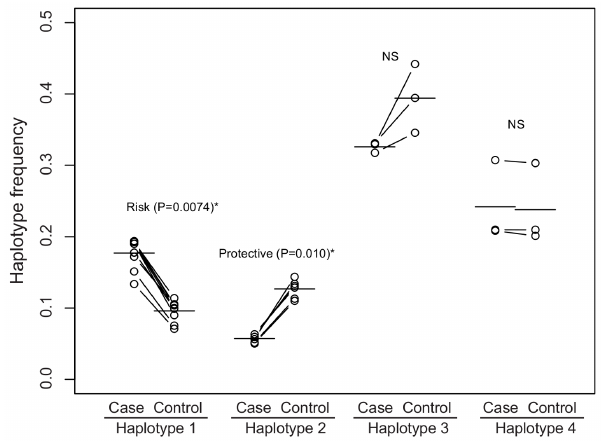
Figure 4. Haplotype frequencies in case and control pools. The haplotype frequencies were estimated from allele frequencies of tag SNPs with r 2 . 0.9 (N=9, 6, 3 and 3 for haplotype 1, 2, 3 and 4, respectively). The horizontal line indicates the average allele frequency among tag SNPs. The difference in allele frequency between cases and controls was tested by Fisher’s Exact Test. NS denotes ‘‘not